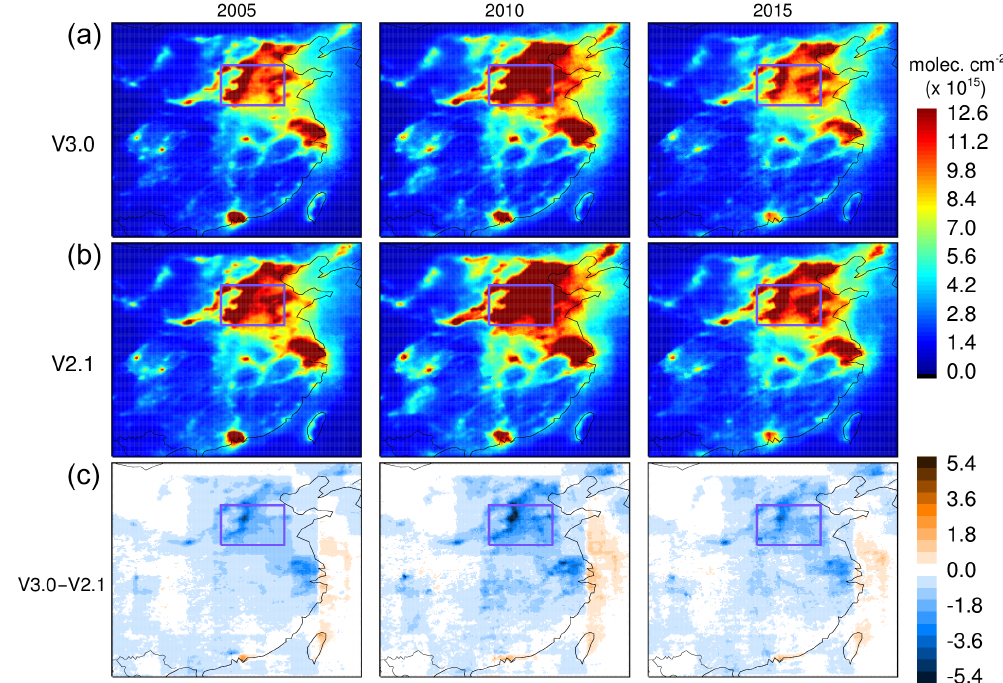
Figure 8. OMI SPv3 (a) and SPv2.1 (b) and difference V trop maps (c) over eastern China for 2005, 2010, and 2015. The box outlines the densely populated and industrialized region in the North China Plain (NCP in Fig. 6). The region has been discussed in Krotkov et al.